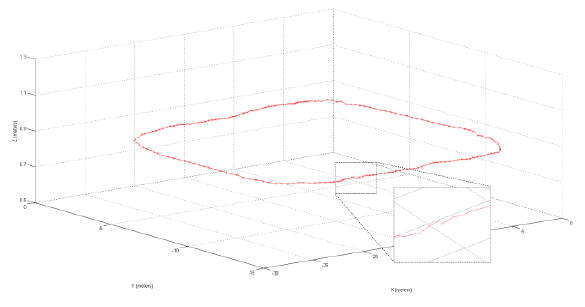
Figure 3. Loop-close trajectory